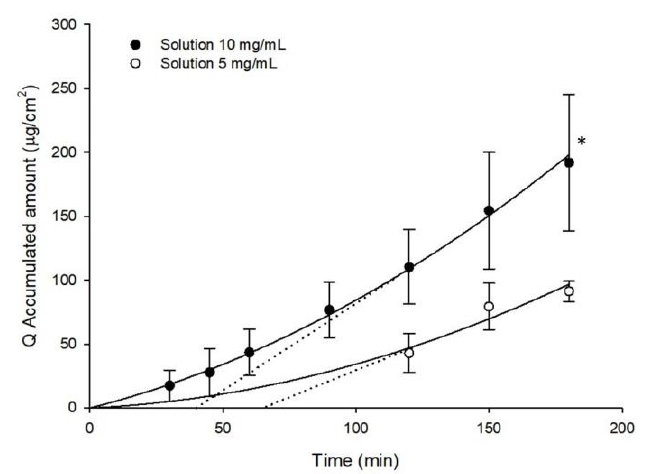
Figure 2. Accumulated amounts of GSH in the receptor compartment (Q, μg/cm 2 ) as a function of time, obtained from samples employed in ex-vivo trans-corneal diffusion studies of different solutions. The dotted line represents the estimated lag time (t 0 ) calculated by intersecting with the x - axis of the linear regression. (Mean ± SD; n ≥ 3) * p < 0.05.